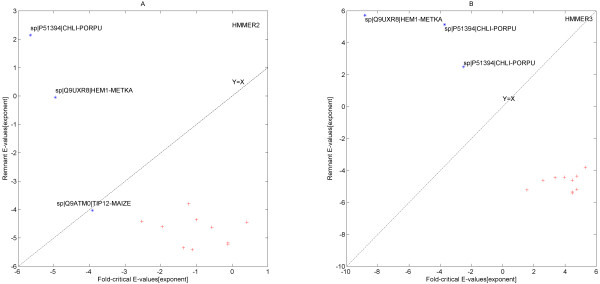
HMMER2 versus HMMER3 average domain score (averaged over all). When the fold-critical and remnant scores (see Table 1, columns 5 and 6) were considered, the distinction between the true and false hits becomes apparent. The Y = X margin depicts two regions: above is where the fold-critical E-values were smaller than the reminant E-values and below as vice-versa. As a general trend, the fold-related scores of hits IF2P_HUMAN, IF2P_MOUSE, IF2P_PONAB, NUCL1_ORYSJ, MLL2_MOUSE, CORTO_DROME, DHKL_DICDI, AMOT_MOUSE, NUCL_HUMAN and PK4_DICDI (see red points) were much smaller than the remnant scores indicating that they are spurious hits and their corresponding fold-related E-values spans from 2.9e-2 to 2.6 (HMMER2) and 3.6e + 1 to 2.0e + 5 (HMMER3) against the more significant remnant segments’ E-values ranges of 3.6e-6 to 1.0e-4 (HMMER2) and 5.5e-27 to 3.3e-1 (HMMER3). In contrast, the fold-related scores were larger than the remnant scores for hits CHLI_PORPU, HEM1_METKA (see blue points). For TIP12_MAIZE (see blue point), the difference between its fold-related and remnant scores was marginal. The corresponding fold-related E-values of 1.2e-4 to 2.2e-6 (HMMER2) and 3.1e-3 to 1.5e-9 (HMMER3) were more significant than the remnant segments’ E-values of 9.4e-5 to 1.4e + 2 (HMMER2) and 3.1e + 2 to 5.3e + 5 (HMMER3).